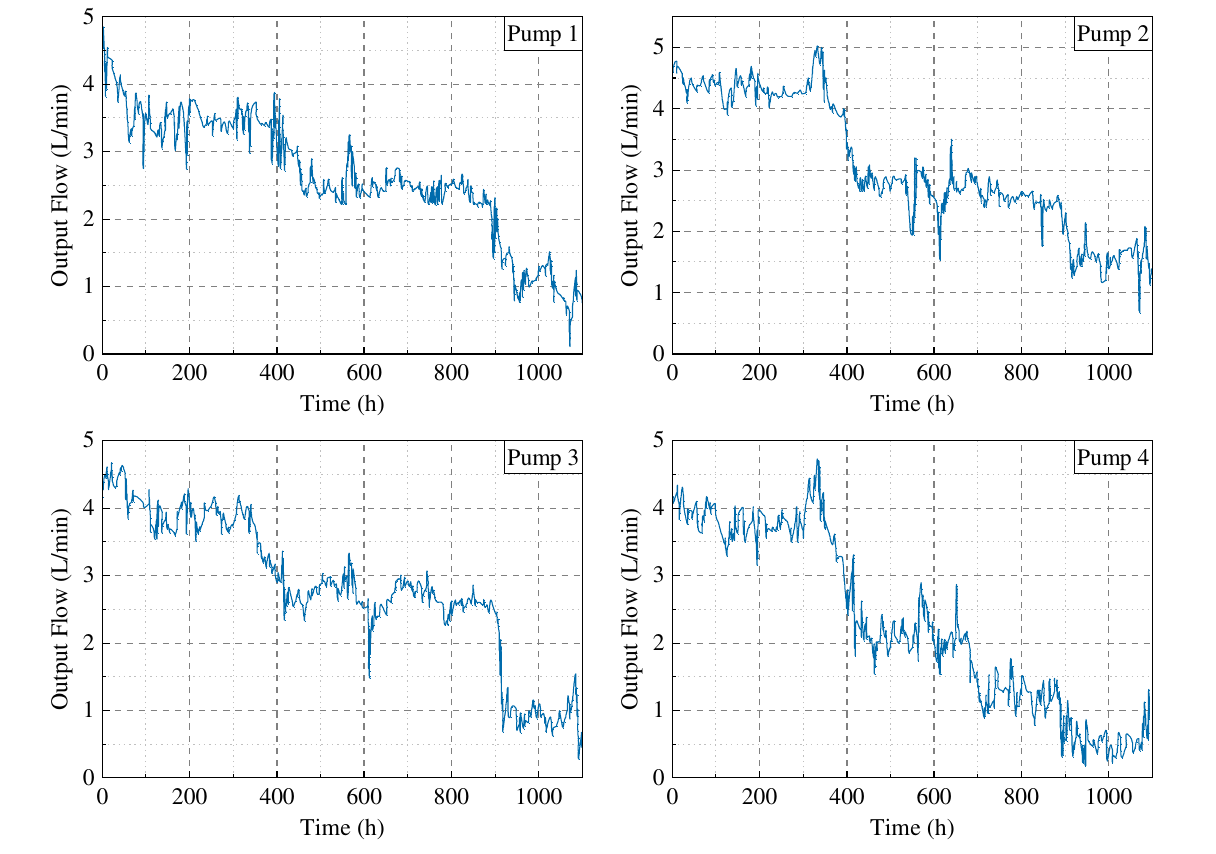
Figure 12. The flow degradation curve of the tested gear pumps.